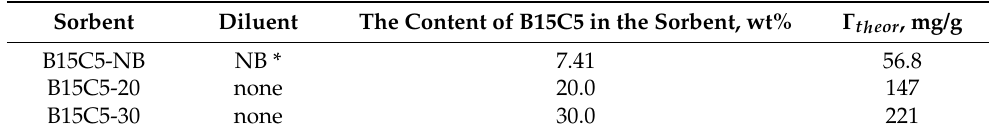
Table 4. Properties of the obtained sorbents. Sorbent